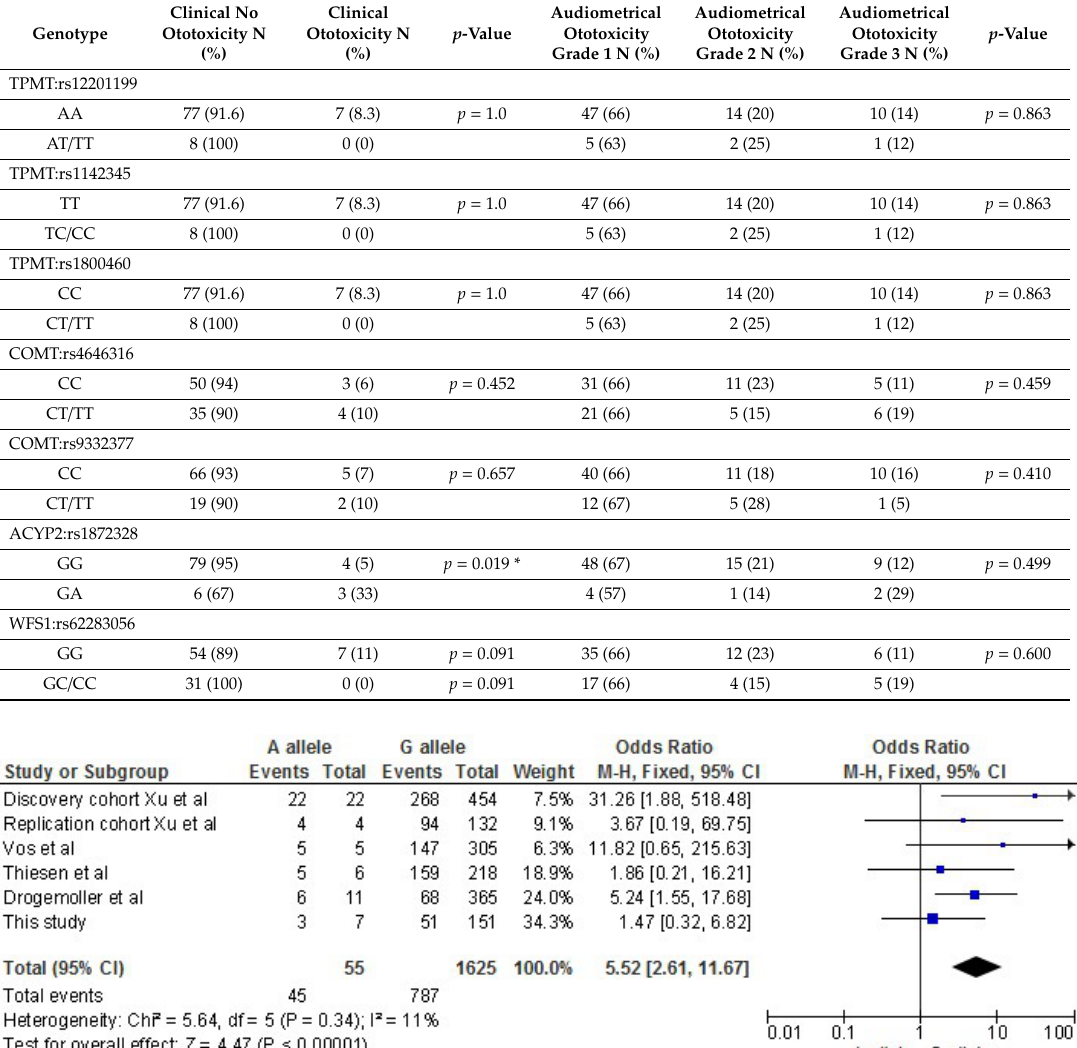
Table 3. Significance levels for genetic variants related to ototoxicity. * = significantly di ff erent ( p < 0.05).